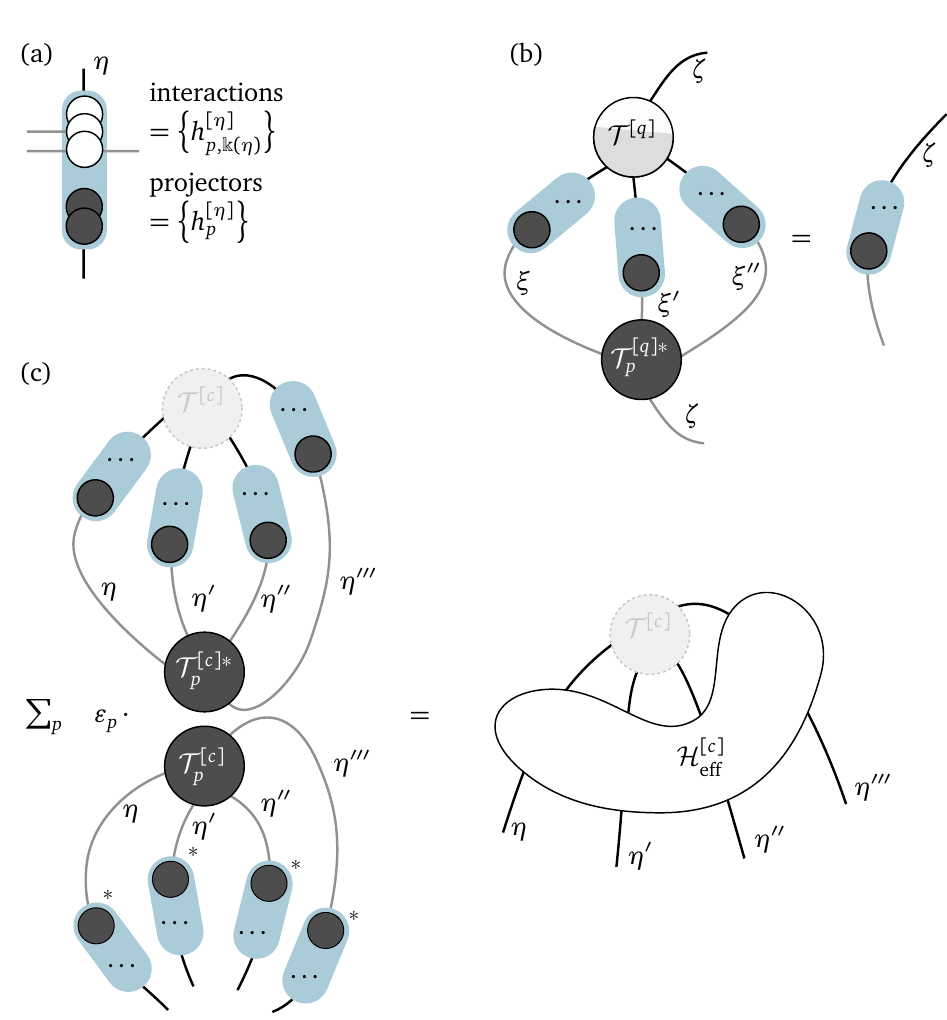
Figure 40: Adding projectors to the Hamiltonian: a) (Renormalized) local projection operators are put on the links. Contrary to interactions which act non-trivially on physical links, projective terms are always identities on physical links. b) Similarly to the renormalization of TPO interactions, projectors are renormalized to a virtual link ζ of a node q by contracting over all local projection operators on the remaining [ q ] ∗ node links η , η (cid:48) , η (cid:48)(cid:48) , with the conjugate tensor T now taken from the projector p TN. The renormalized projectors h [ ζ ] have no TPO links, but in contrast to the rule p for TPO interactions they cannot be summed up over p (every projector results in a separate renormalized two-link tensor on each link). c) The effective projector at the center c is given by the contraction of the renormalized projectors over all links with the conjugated projector-tensor T [ c ] ∗ . The resulting expression is then p multiplied by its complex conjugate. This contraction has to be repeated for every p in the global Hamiltonian sum individually, constituting one summand of the complete [ c ] effective Hamiltonian H . As before, we show the center tensor (semi-transparent) eff to demonstrate how the effective projector acts upon